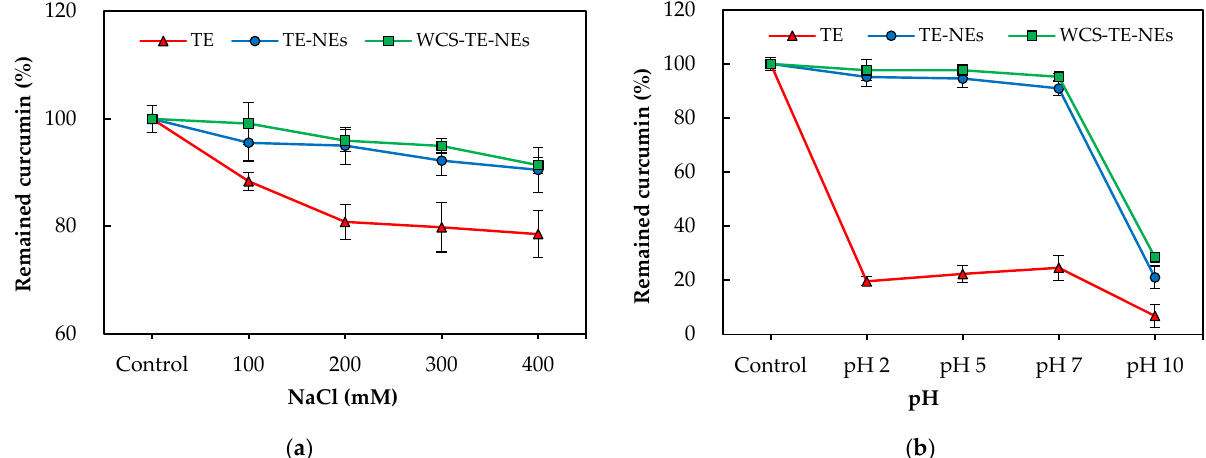
Figure 5. Effect of NaCl concentrations ( a ); pH changes ( b ) on the physicochemical properties of the TE, TE-NEs, and WCS-TE-NEs.